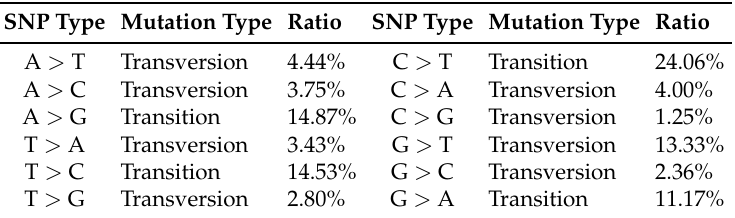
Table 1. The distribution of 12 SNP types among unique mutations in the SARS-CoV-2 genome isolates worldwide. The unique SNP mutations are considered in the calculation, i.e., the same type of mutation in different genome isolates is only counted